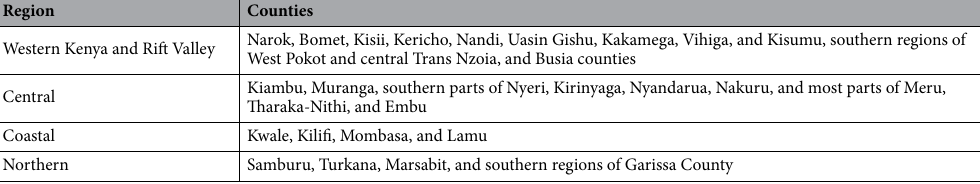
Table 4. Counties identified to be at high risk of livestock, human, and wildlife anthrax disease by region.